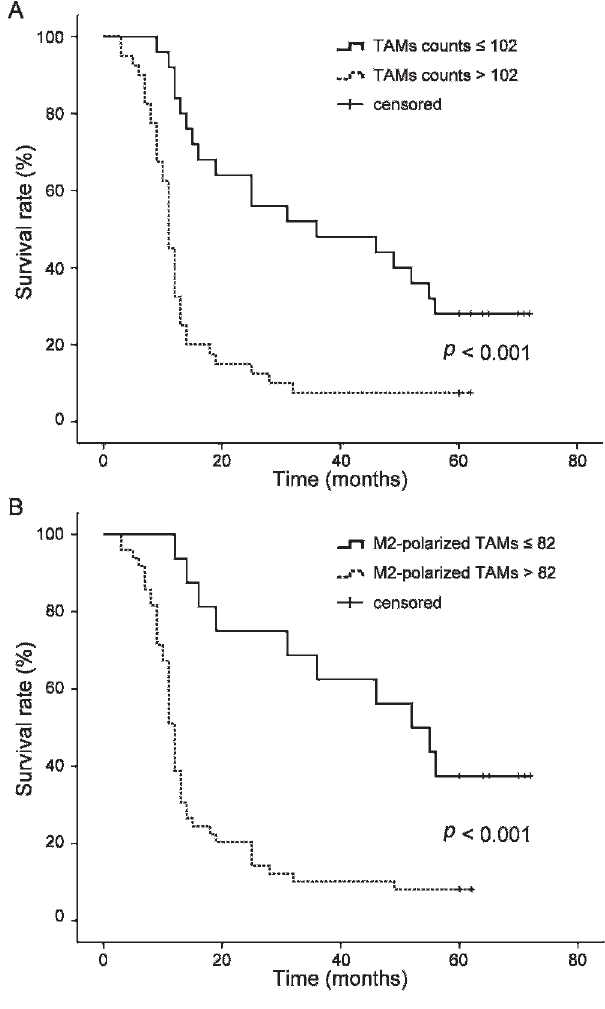
Figure 4 - Kaplan-Meier curves for overall survival by TAM count (A) and M2-polarized TAM count (B) in patients with lung adenocarcinoma. A shows the difference in the overall survival rate between the high and the low TAM count groups ( p , 0.001). B shows the difference in the overall survival rate between the high and the low M2-polarized TAM groups ( p , 0.001).